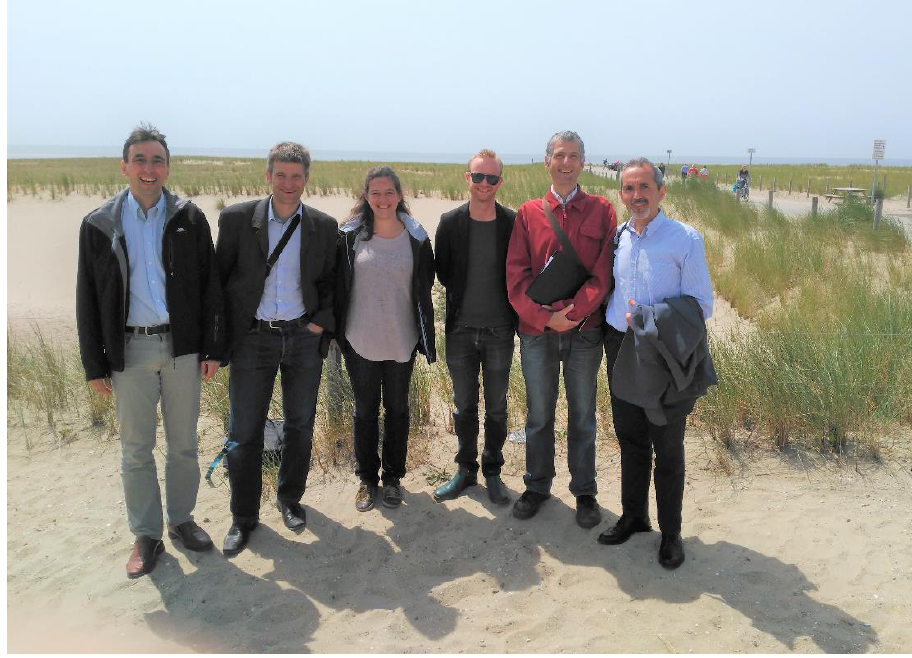
Figure 2. Dr. Pfrang’s research group.